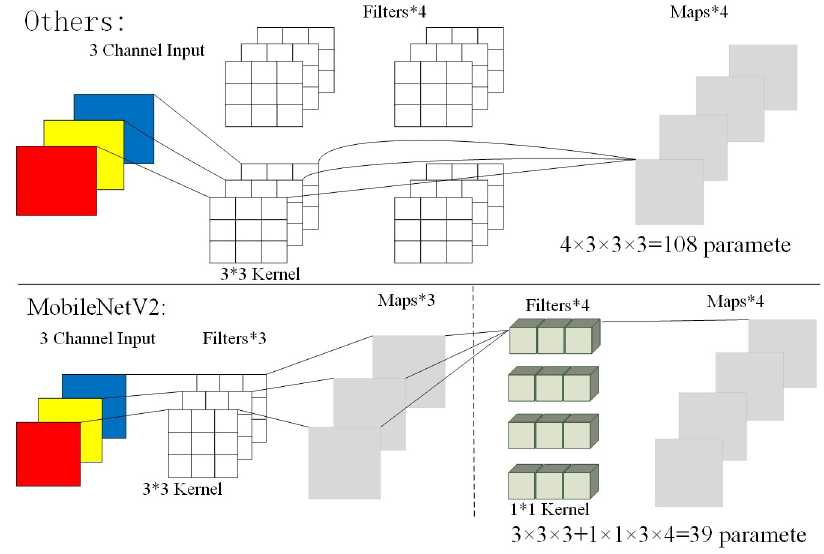
Fig 2. The parametric comparison between the MobileNetV2 network and the rest of the